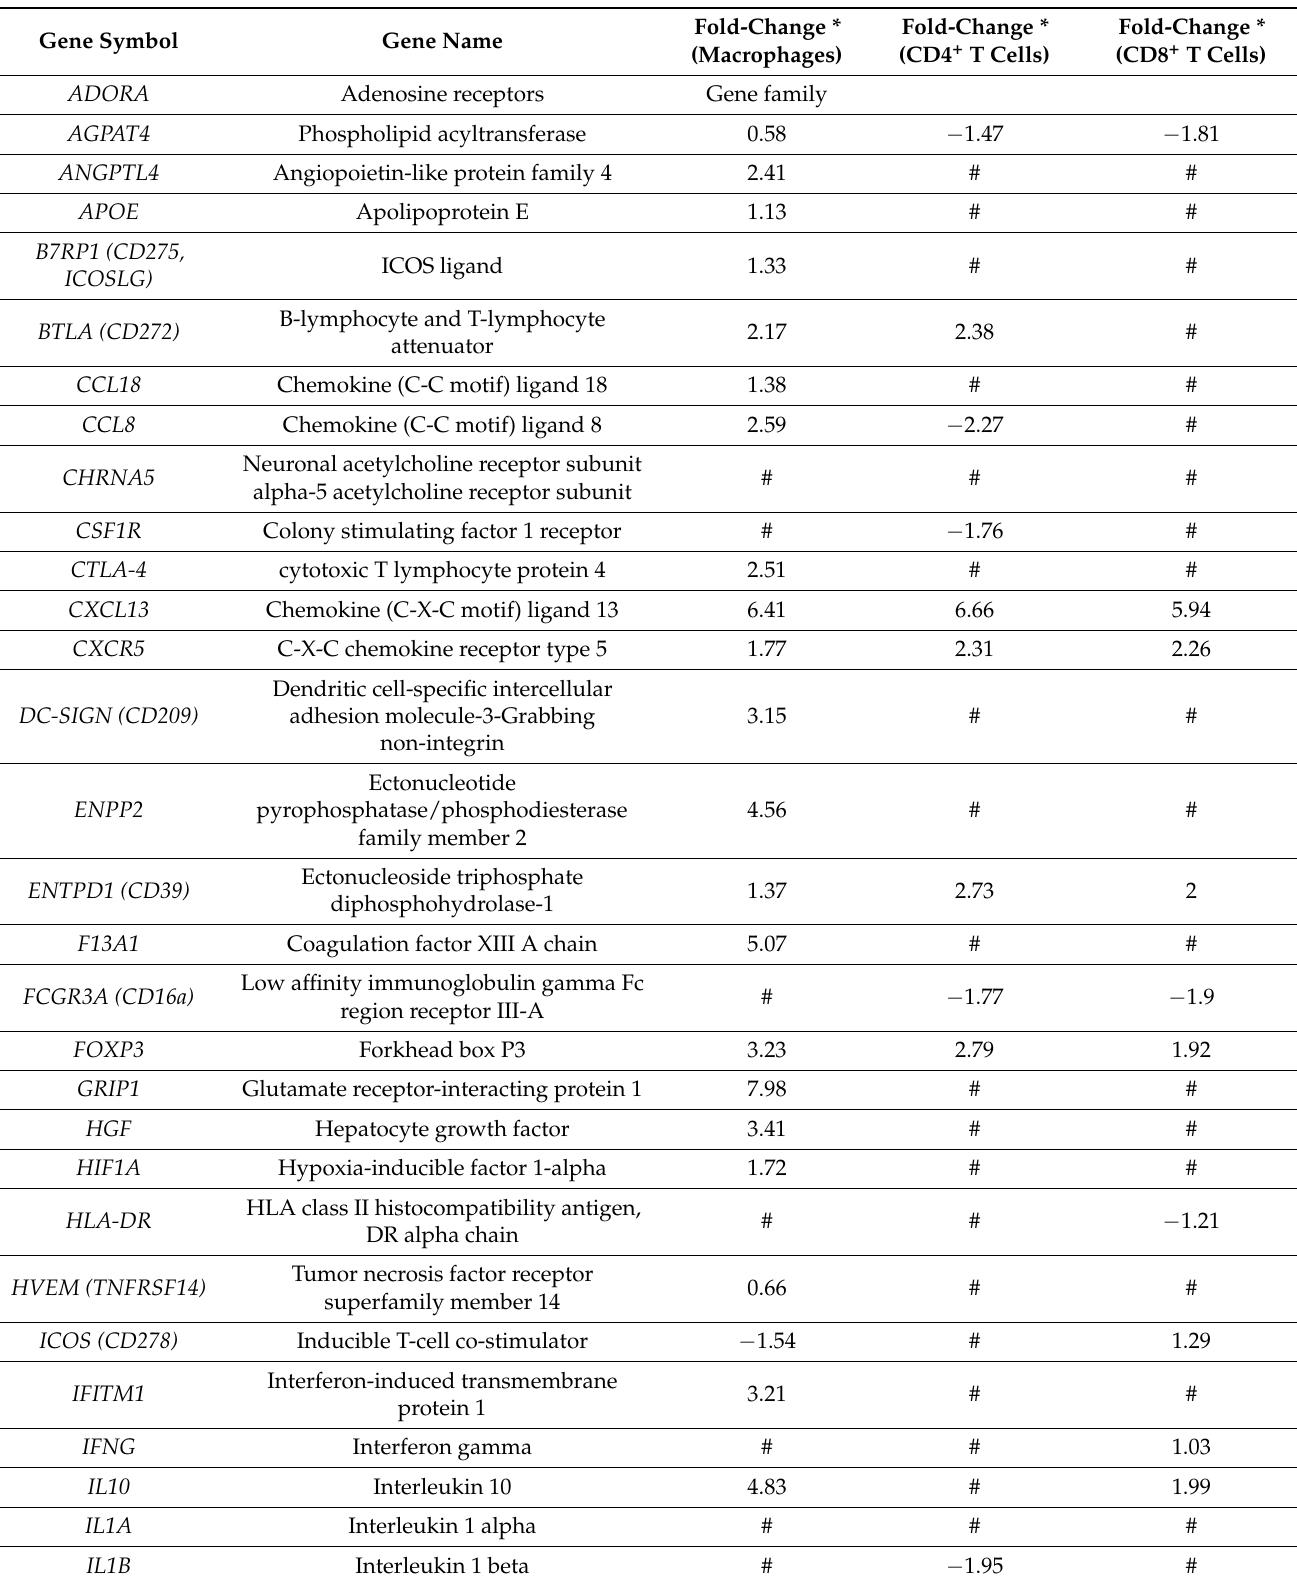
Table 2. Ratio between gene expression in cells from non-small cell lung carcinoma tissues and from healthy tissues for macrophages and T